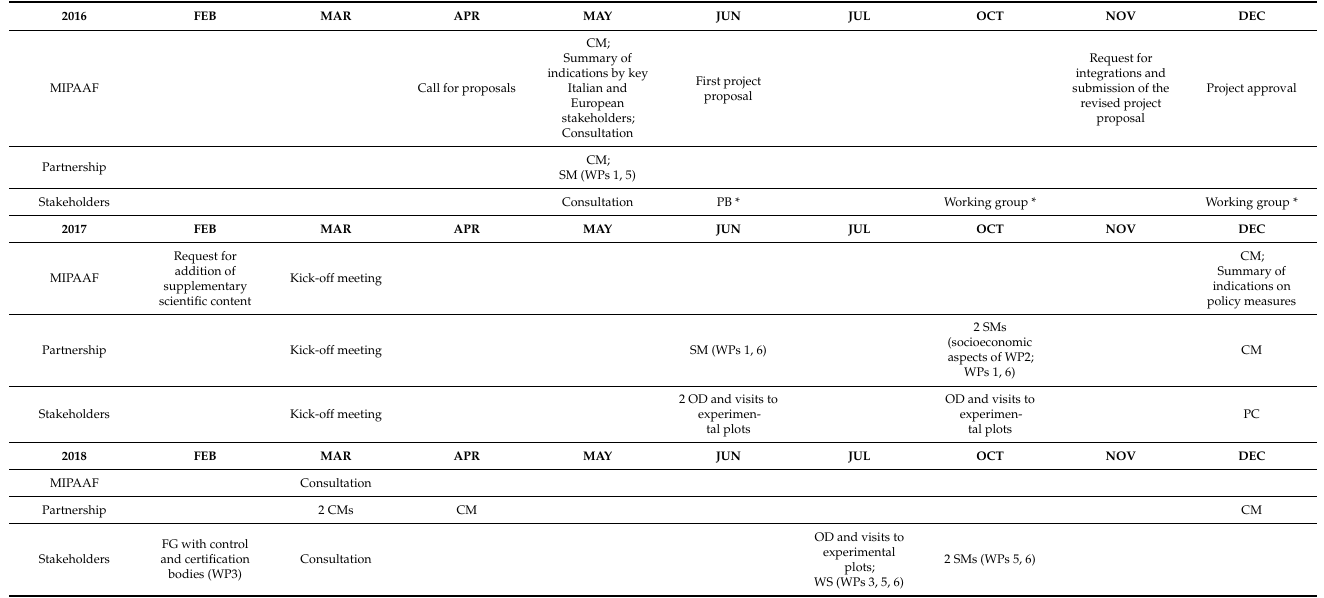
Table 4. Main interactions during the RBS